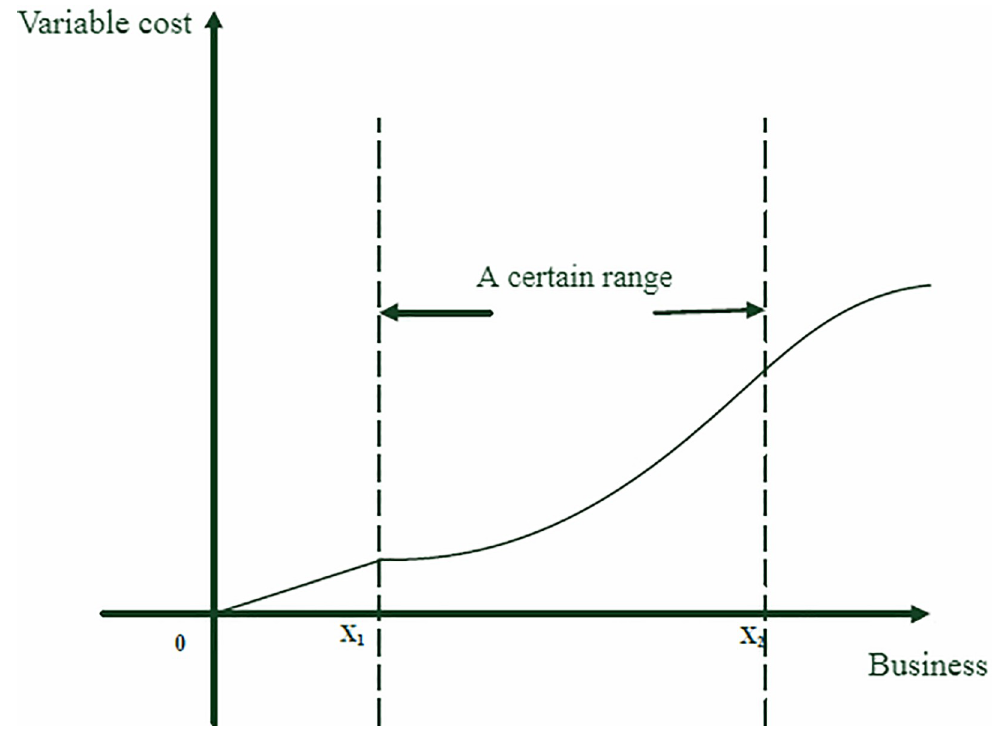
Fig 1. Variable cost